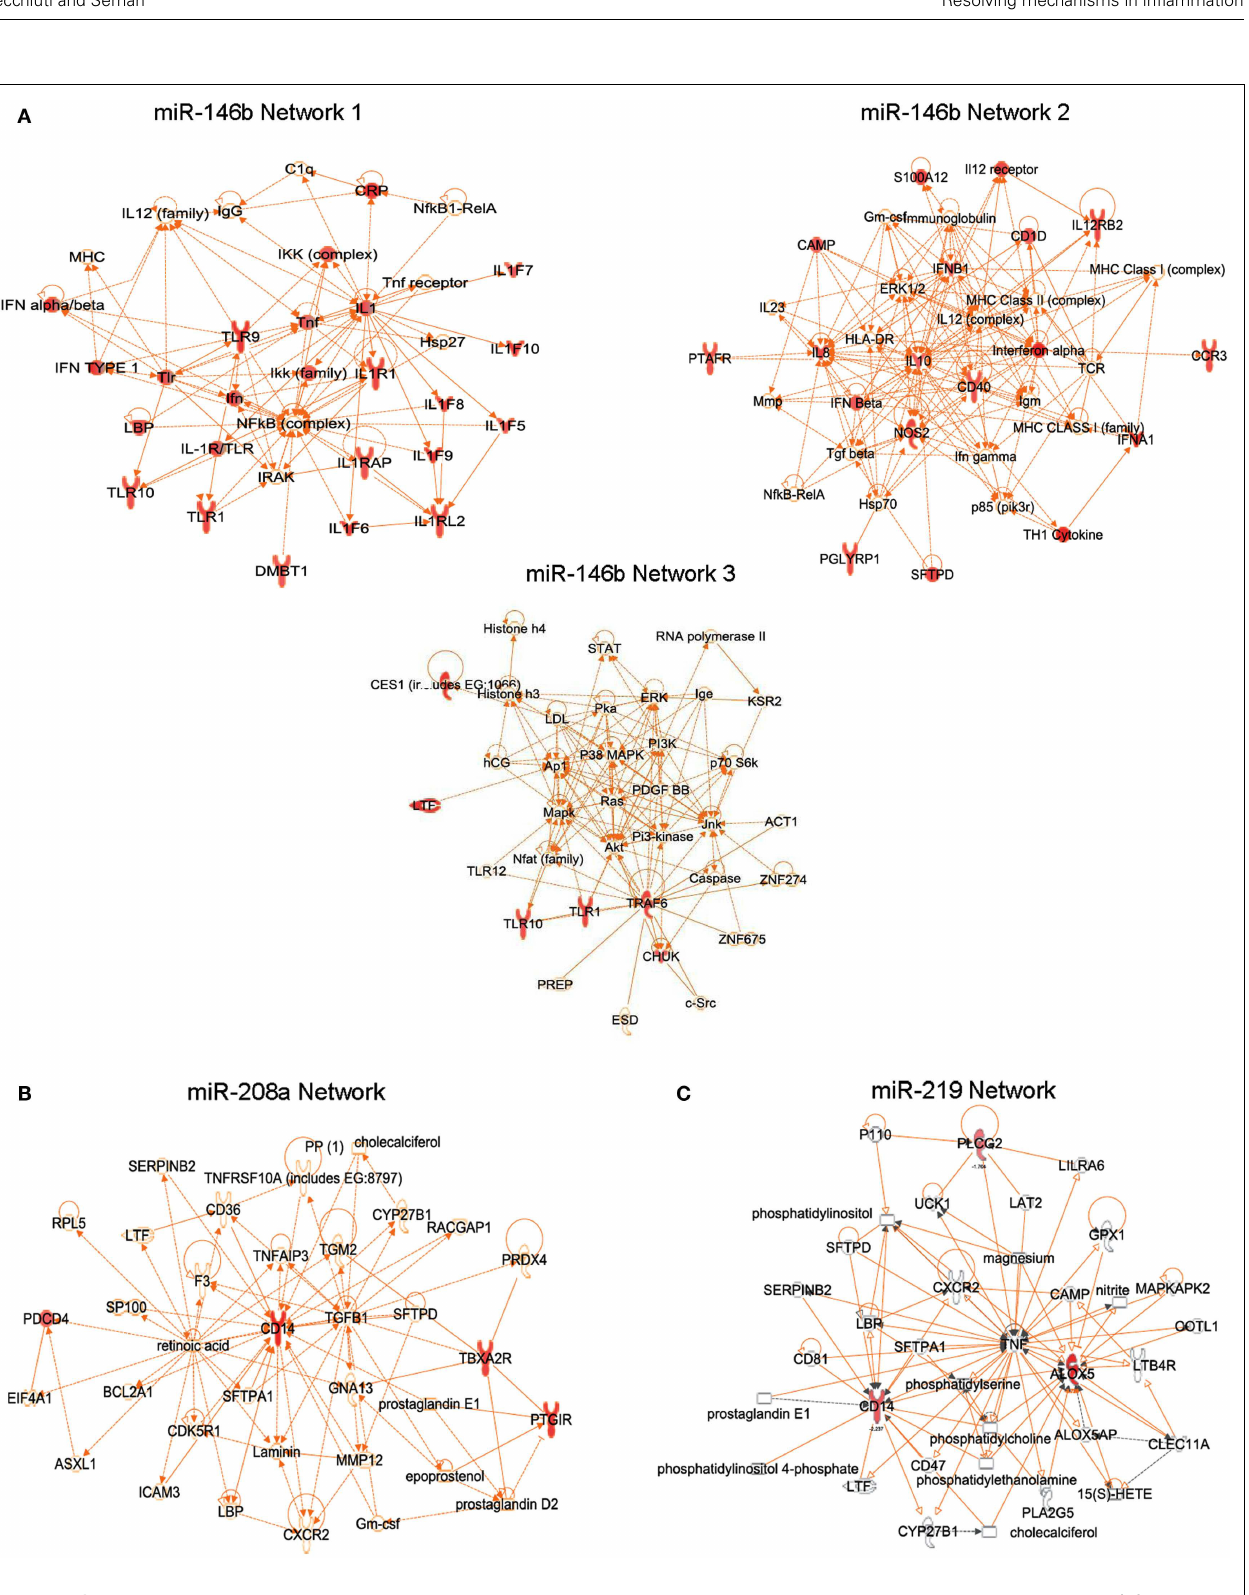
FIGURE 8 |Translation of RvD1-dependent miRNA circuits in human cells. RvD1-GPCR gene networks connecting target genes of miR-146b (A) , miR-208a (B) , and miR-219 (C) . Genes that are significantly down regulated in each network are indicated in red.